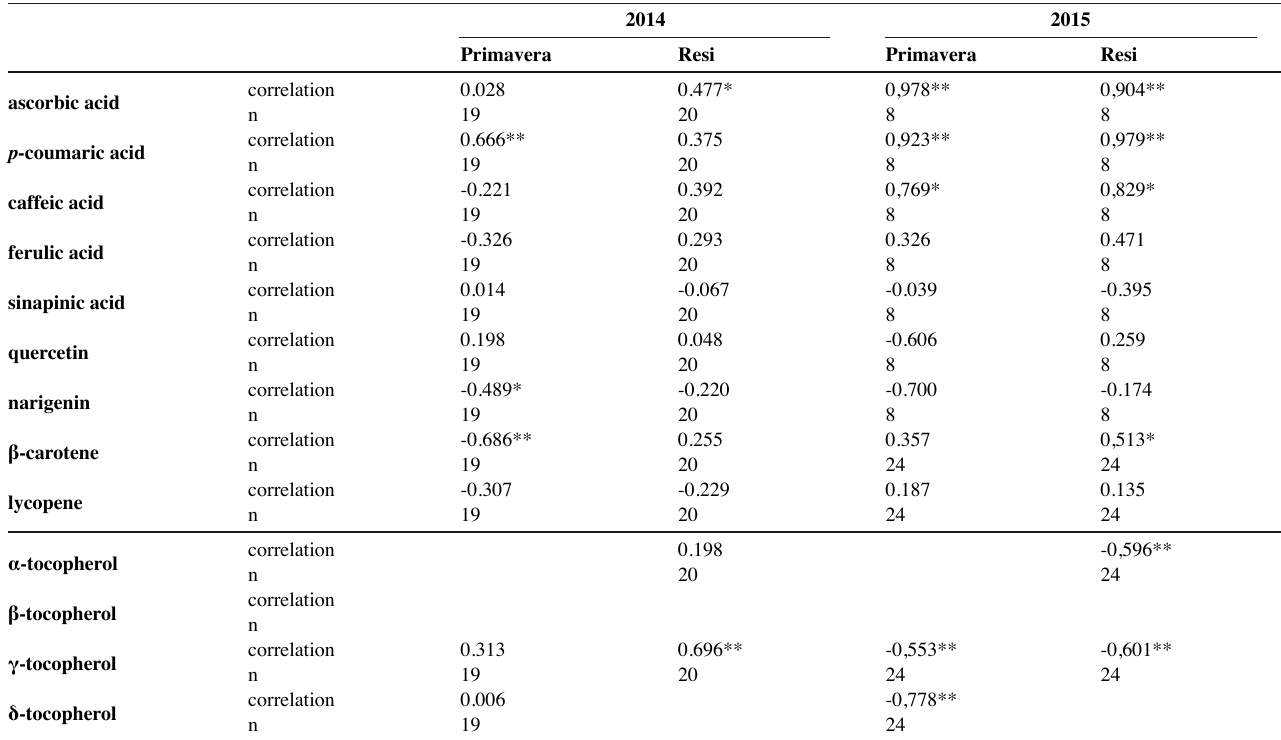
Tab. 1: Pearson correlation between the concentration of K and antioxidants in tomatoes.